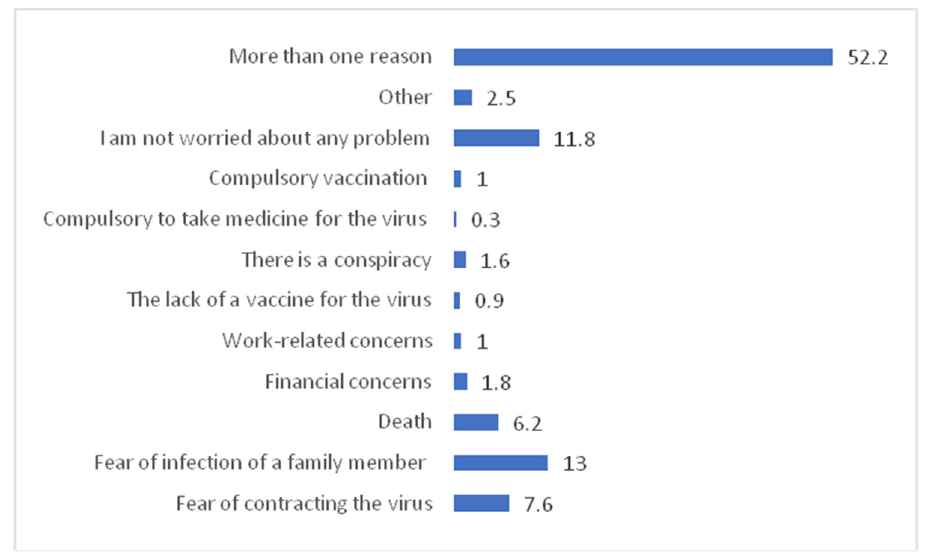
Figure 4. What worries parents faced the most during the COVID-19 pandemic? Figure 5 depicts that the parents’ attitudes towards vaccination, immunity, and the coronavirus (COVID-19) pandemic. In which majority of parents strongly agreed 306 (20.9%) and agreed 541 (37.0%) that vaccines are generally considered safe. Parents who believe that COVID-19 vaccine is more dangerous for children than adults among them almost half of them 225(47.8%) showed hesitancy for their children being vaccinated, 126 (56%) have concerns that Corona vaccine affects child genes, majority of them 57 (60%) were not willing to give the vaccine to prevent Coronavirus disease to your children, half of them 65 (52%) showed concerns that the COVID-19 vaccine could affect your son/daughter’s puberty or fertility and 167 (45.6%) had any bad side effects from receiving vaccinations in the past whereas statistical significance differences were